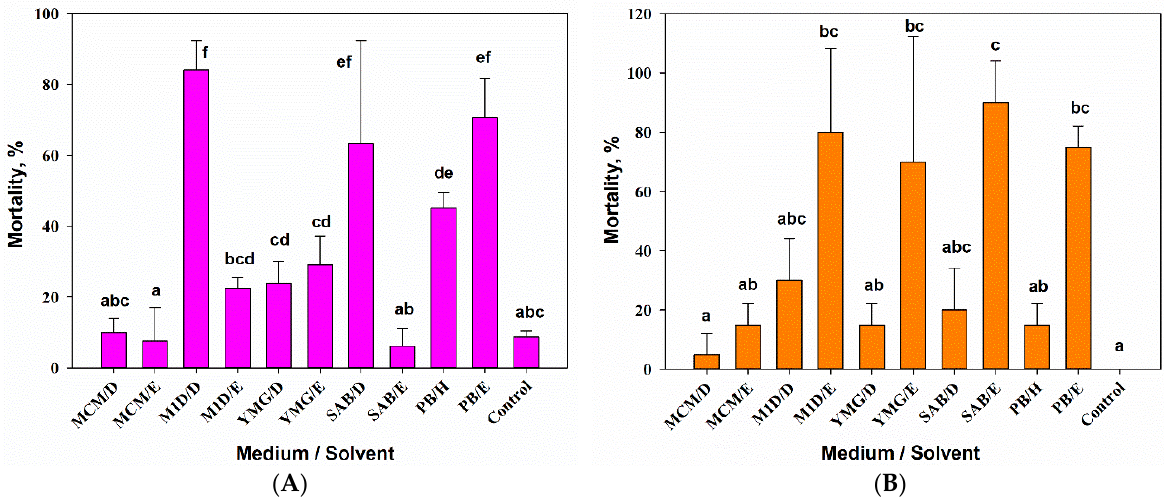
Figure 2. Entomotoxic activity of extracts from Alternaria tenuissima MFP253011 cultures on various liquid and solid nutrient substrates on Schizaphis graminum at a concentration of 5 mg/mL 24 h post treatment ( A ) and on Galleria mellonella at a concentration of 50 µg/larva 7 days post treatment ( B ). Means ± std. deviation marked with the same letter did not differ significantly at the level of p = 0.05 according to Tukey’s HSD test. D—dichloromethane, E—ethyl acetate, H—hexane.